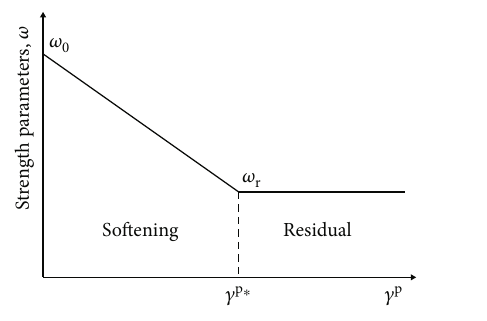
Figure 3: Evolution curve of strength parameters [23].